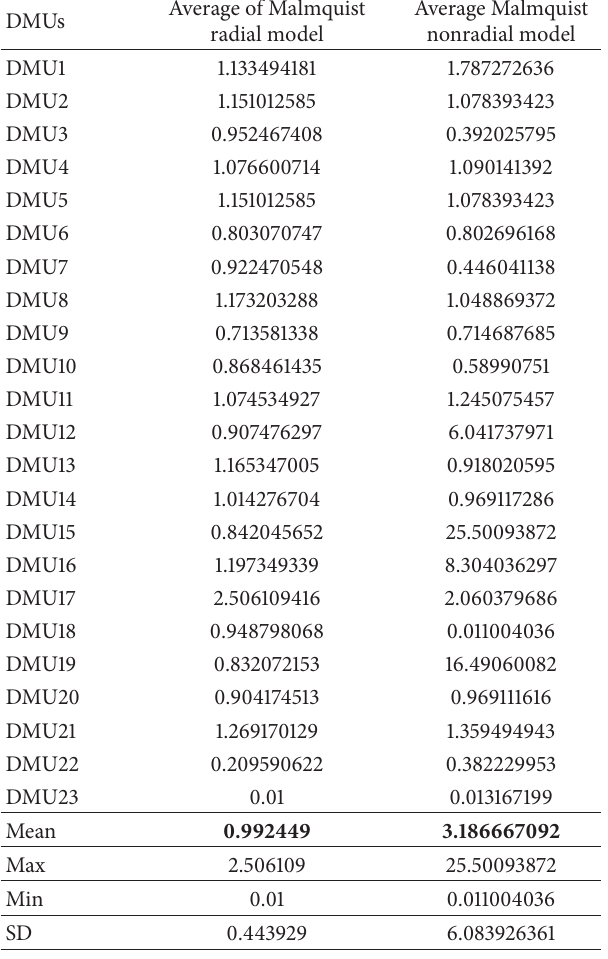
Table 10: The average indices of Malmquist radial and Malmquist nonradial models.